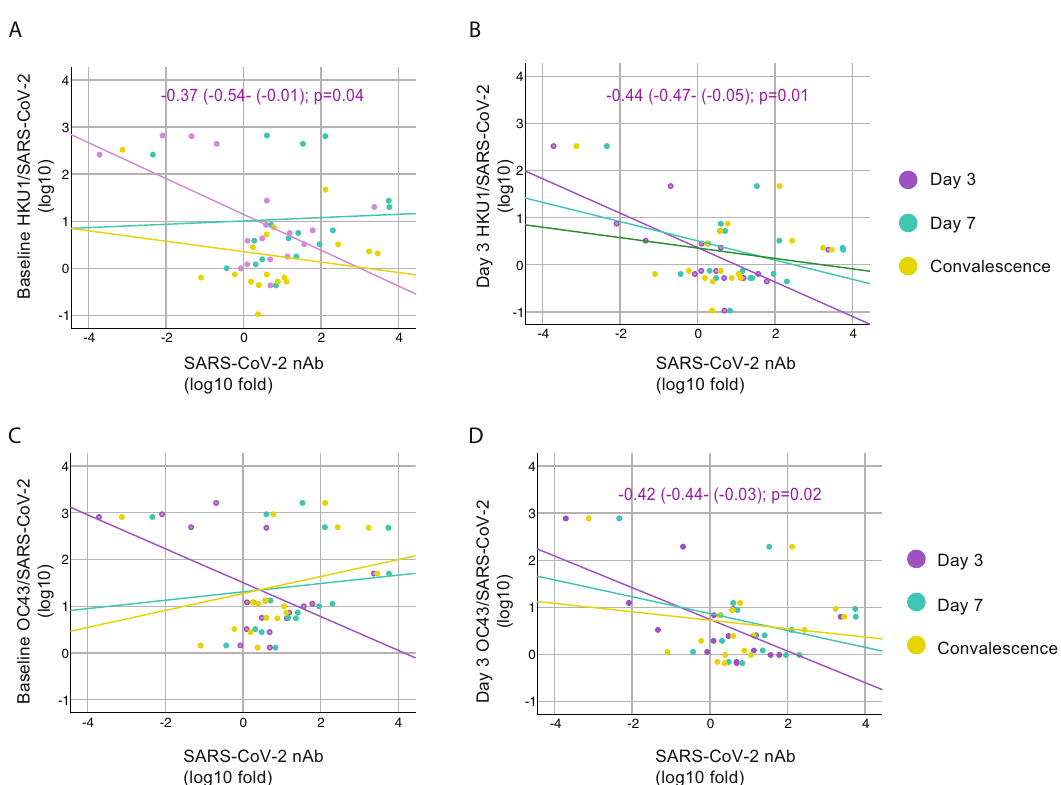
Fig. 7 In fl uence of levels of back-boosting to HKU1 and OC43 normalized by levels of anti- SARS-CoV-2 antibodies on neutralizing antibodies induction. A – D Scatterplot of baseline and day 3 IgG levels for HKU1 and OC43 S protein normalized by the levels of SARS-CoV-2 IgG and their relationships with fold induction of SARS-CoV-2 neutralizing antibodies (nAb) over time. Overlay shows linear regression at each time point. Fitted linear regression and standardized beta coef fi cient (95% con fi dence interval, CI) for signi fi cant regression are shown. Reported p values are based on two ‐ tailed